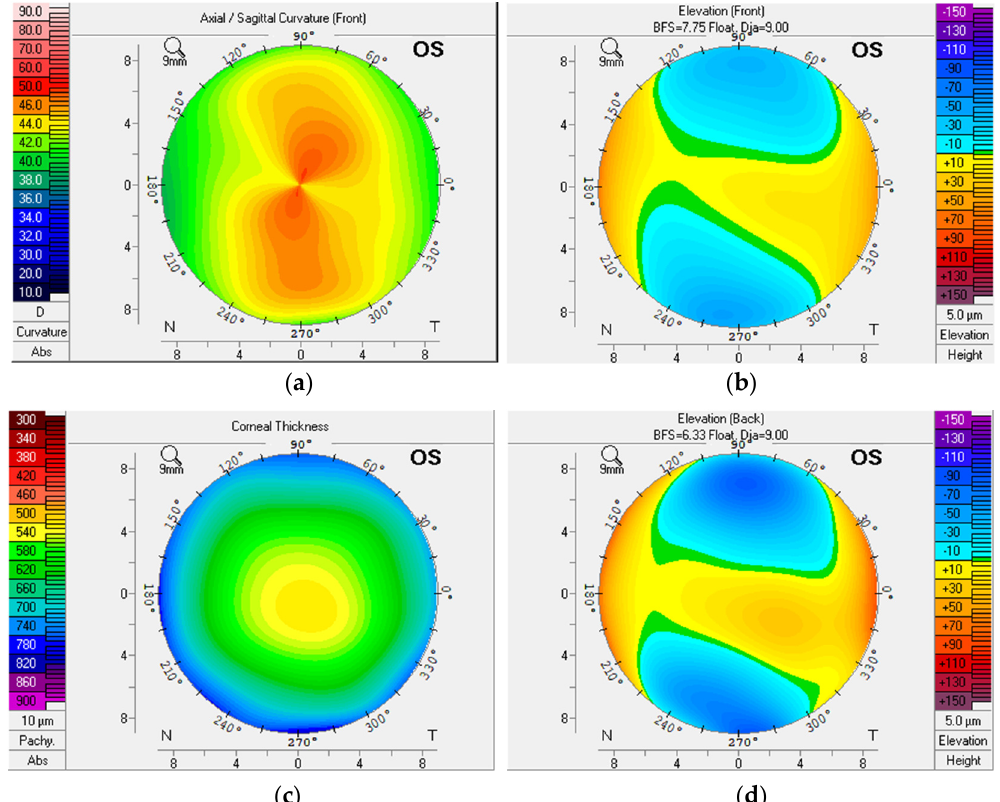
Figure 1. The four corneal maps: ( a ) sagittal, ( b ) elevation front, ( c ) corneal thickness, and ( d ) elevation back maps.